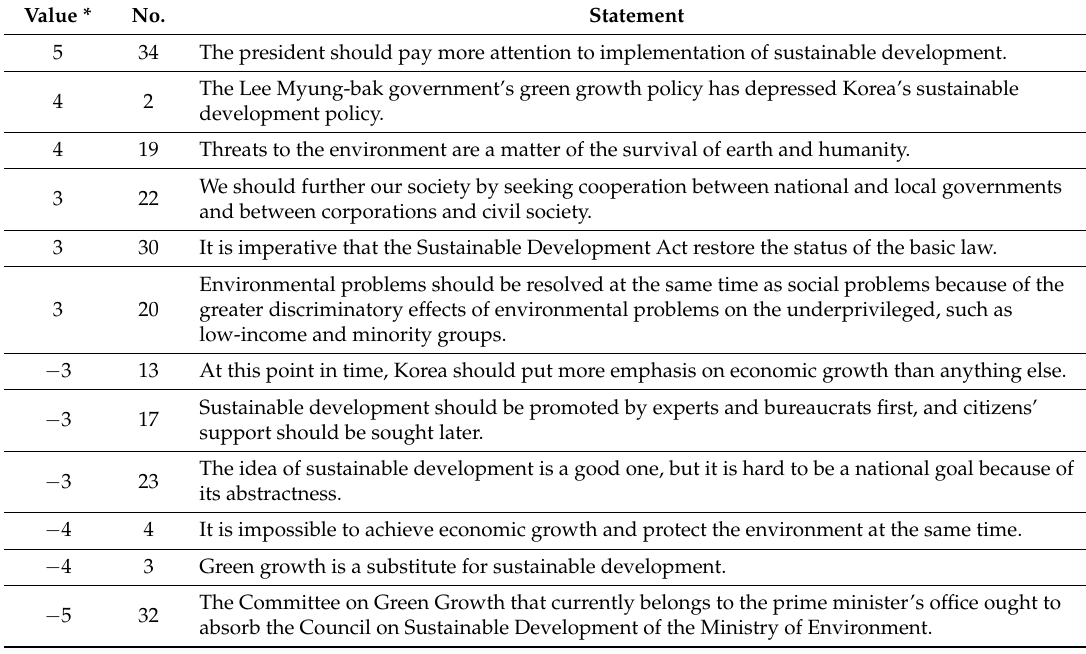
Table 6. Democrats’ Q